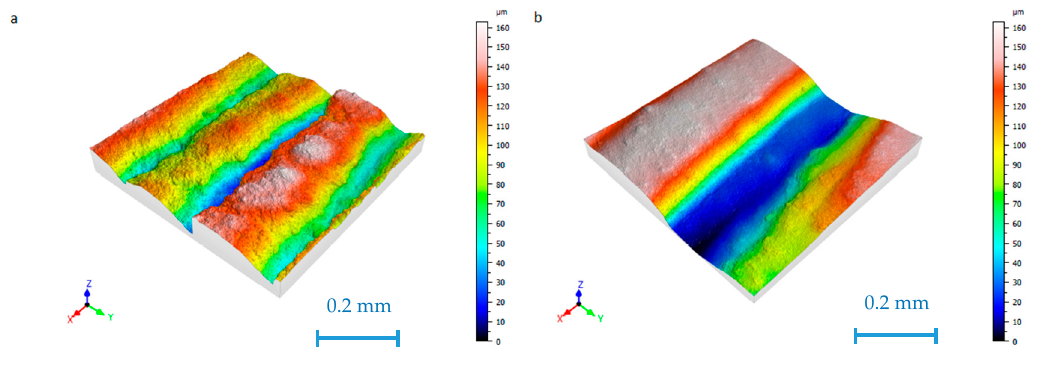
Figure 2. The surface topography of ( a ) sample 5 (Sa = 23.229 μ m) and ( b ) sample 10 (Sa = 27.919 μ m).